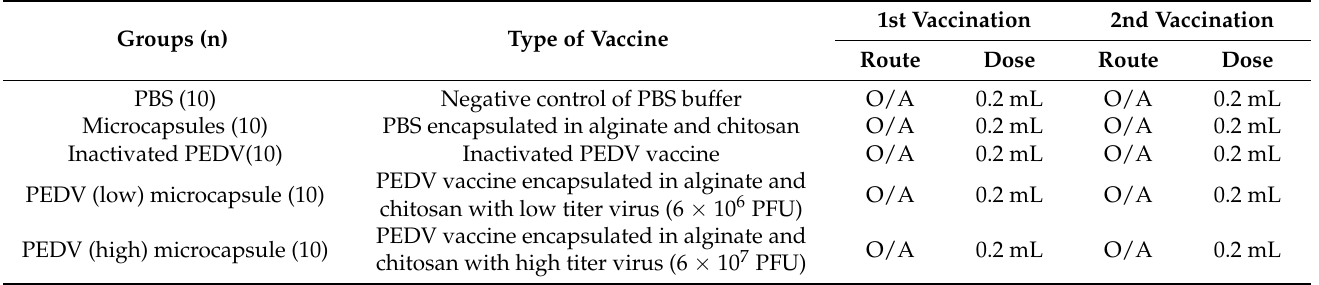
Table 1. Immunization regime of